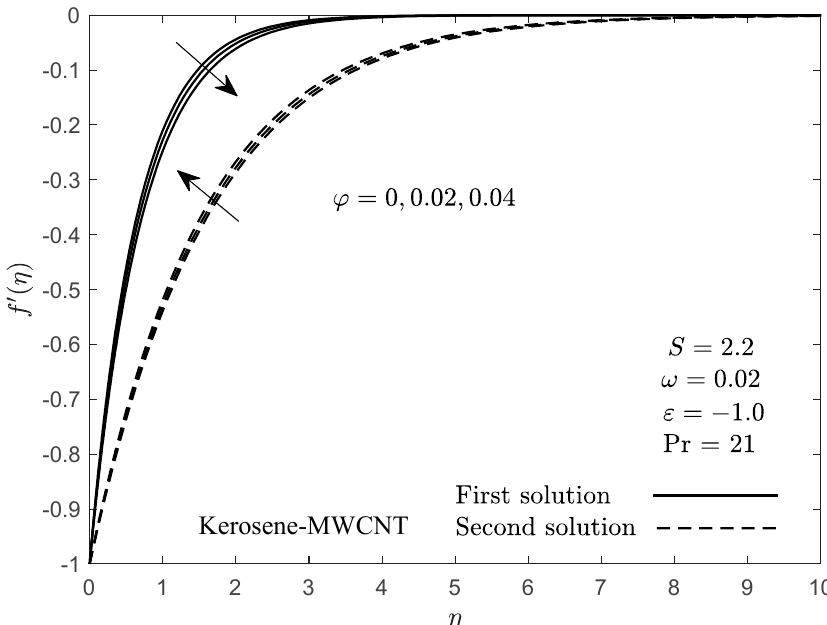
0 Figure 9. Velocity profiles of x -component f (cid:48) ( η ) for some values of ϕ Figure 9. Velocity profiles of 𝑥 -component 𝑓′(𝜂) for some values of 𝜑 . Figure 9. Velocity profiles of 𝑥 -component 𝑓′(𝜂) for some values of 𝜑 .